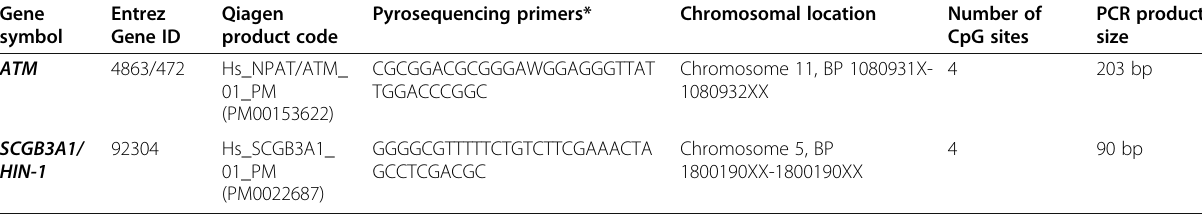
Table 1 The primers used in pyrosequencing